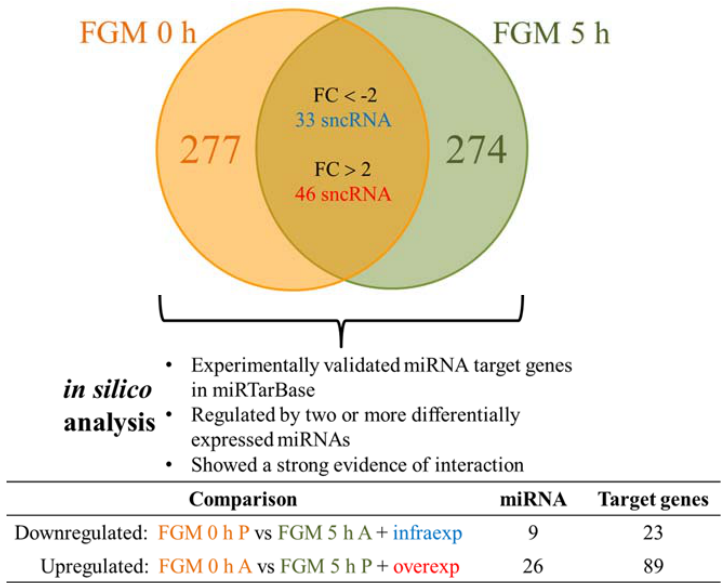
Figure 3. Fingolimod (FGM) modulates the sncRNA cargo in the first 5 h post ‐ treatment. Number of